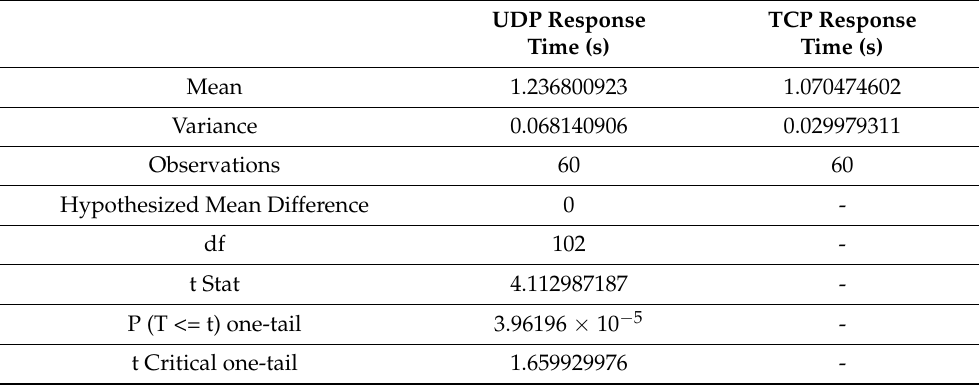
Table 10. Result, Experiment 7.